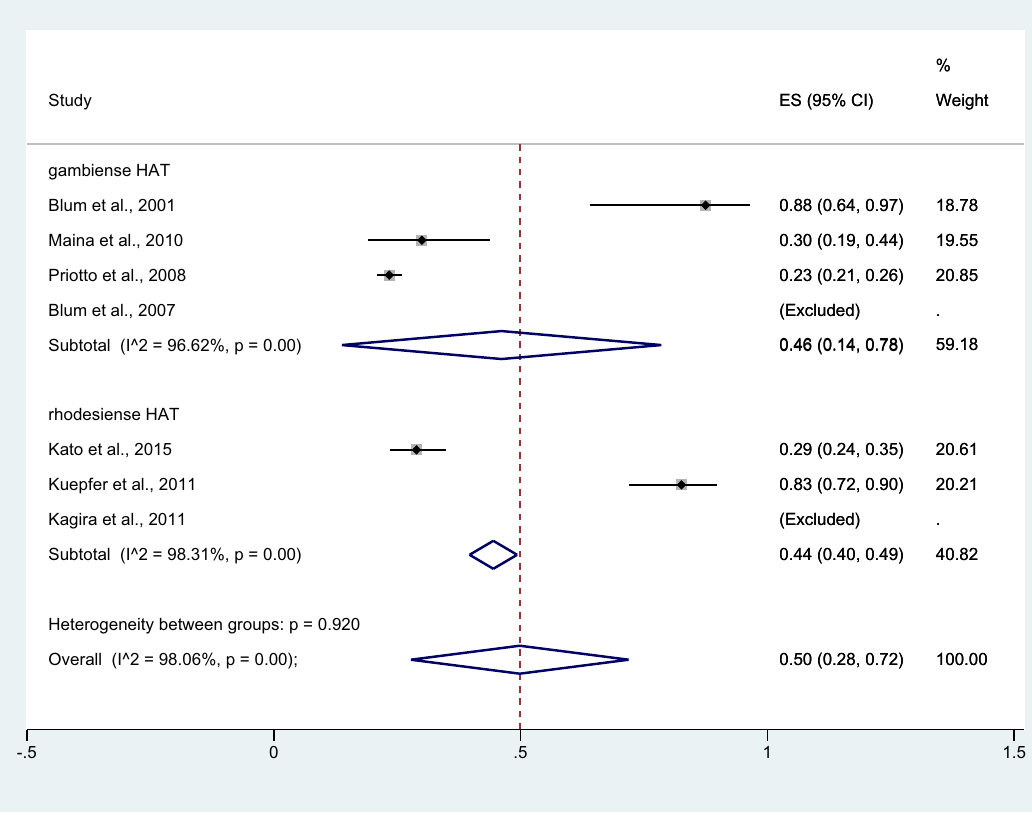
Figure 4. Subgroup analysis of the pooled prevalence of malaria in human African trypanosomiasis by HAT type. ES effect size, CI confidence interval; black diamond symbol, point estimate, Dashed line: pooled prevalence of malaria in human African trypanosomiasis; I 2 , level of heterogeneity; p = 0.00 or less than 0.05, significant